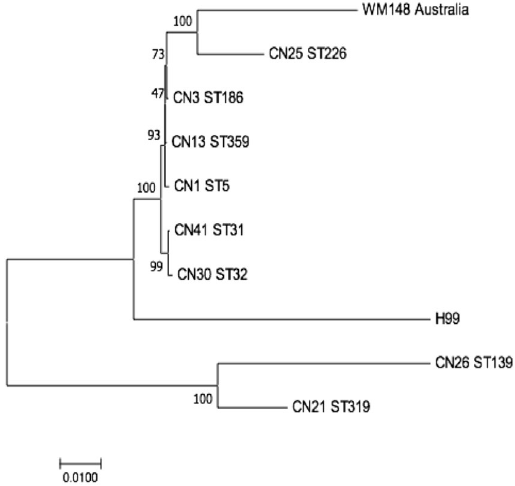
Figure 1. Phylogenetic tree constructed using the Neighbour-joining method, based on the concatenated sequences at seven MLST loci. Only one representative isolate of each ST from Jiangxi Province is shown here. Two reference strains (WM148 and H99) of VNI are included for